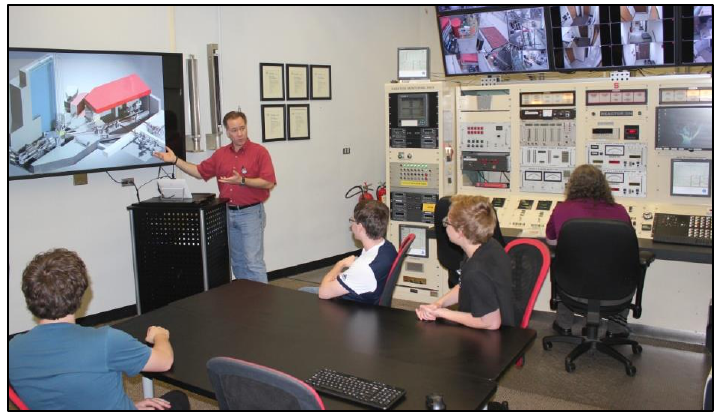
Fig. 4. Cisco telepresence camera view in PULSTAR reactor control